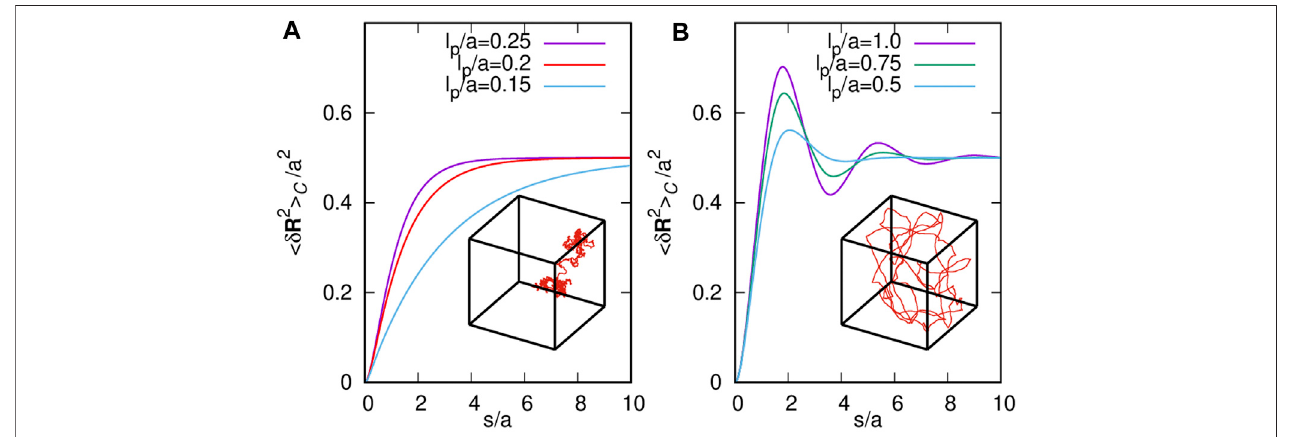
FIGURE 1 | Monotonous and oscillating behaviors of the mean-square end-to-end distance ( Eq. 30 ) of polymers with ℓ p below (A) and above (B) the critical (cid:12)(cid:12) √ / ( 2 π ) a in cubic con fi nement. Inside the plotting area, we sketch the conformational states of each class of 3 persistence length ℓ p p (cid:1)